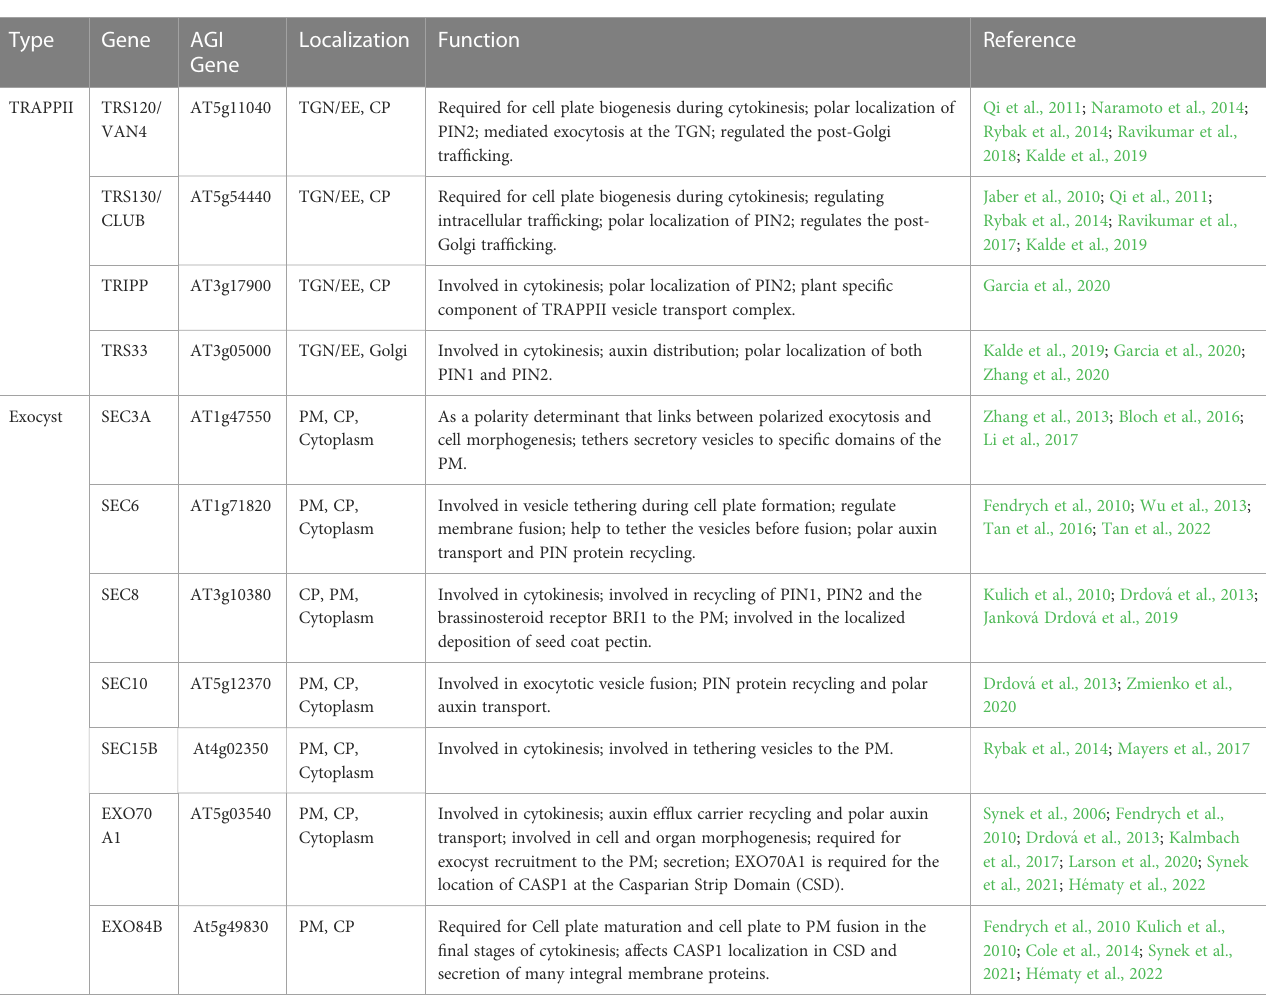
TABLE 2 Characteristics of tethers located in cell